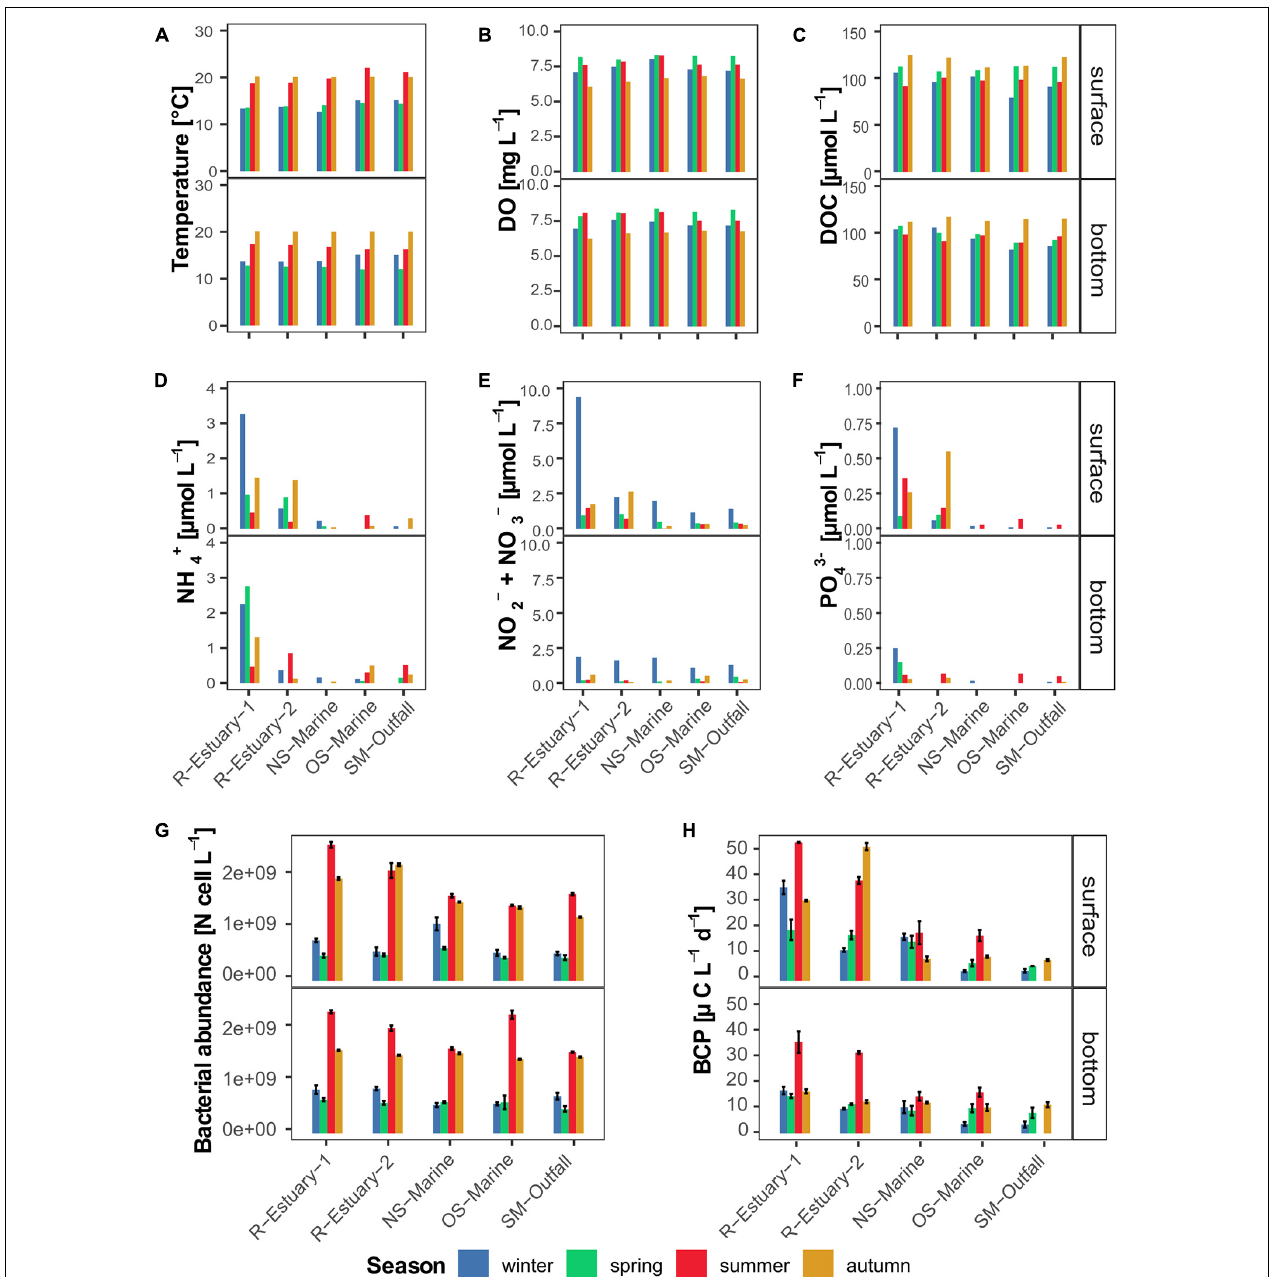
FIGURE 2 | Dynamics of selected environmental parameters at the surface and bottom layer in winter, spring, summer, and autumn during the 2018/2019 survey in the eastern part of the Gulf of Trieste (sampling stations: R-Estuary-1, R-Estuary-2, NS-Marine, OS-Marine and SM-Outfall). (A) Temperature; (B) dissolved oxygen; (C) dissolved organic carbon: (D) ammonium; (E) nitrate and nitrite; (F) orthophosphate; (G) bacterial abundance; (H) bacterial carbon production. Data for bacterial carbon production at SM-outfall in summer are